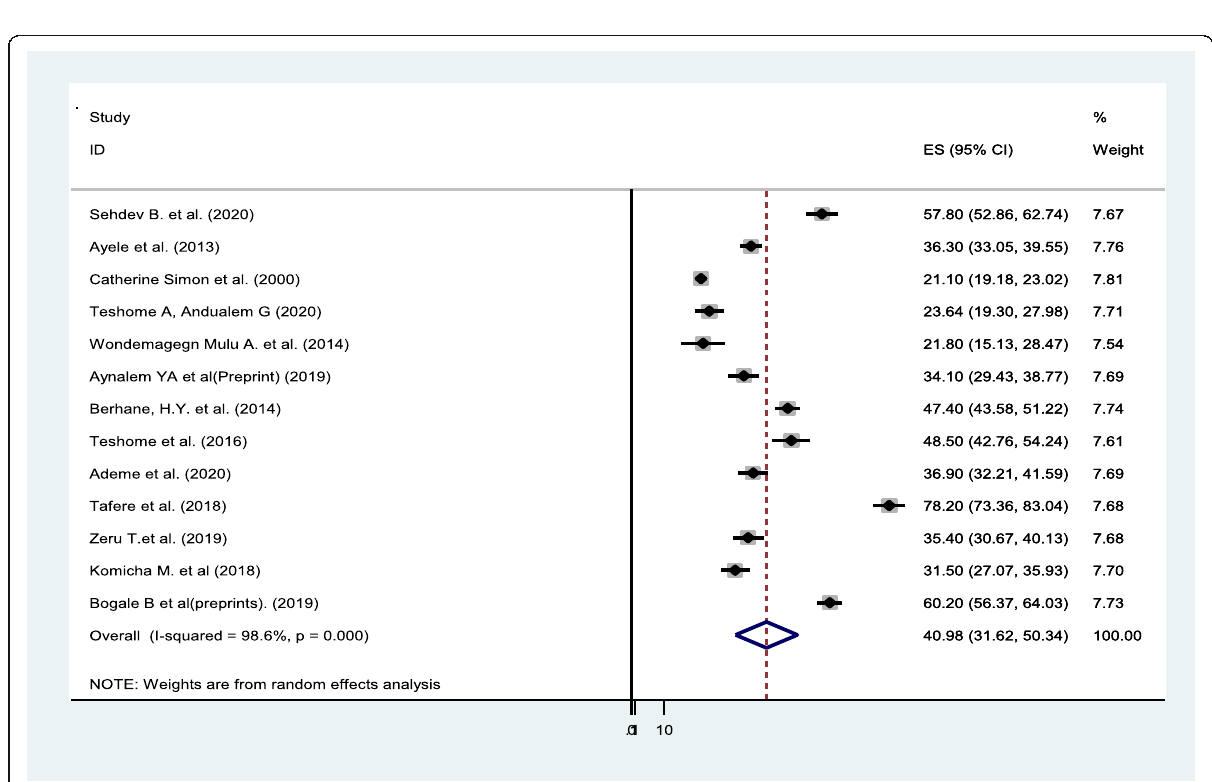
Fig. 2 Forest plot revealing overall prevalence of dental caries in